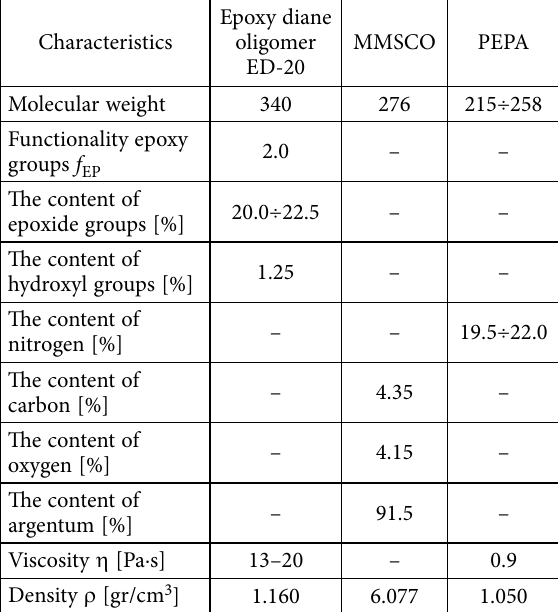
Table. Characteristics of epoxy